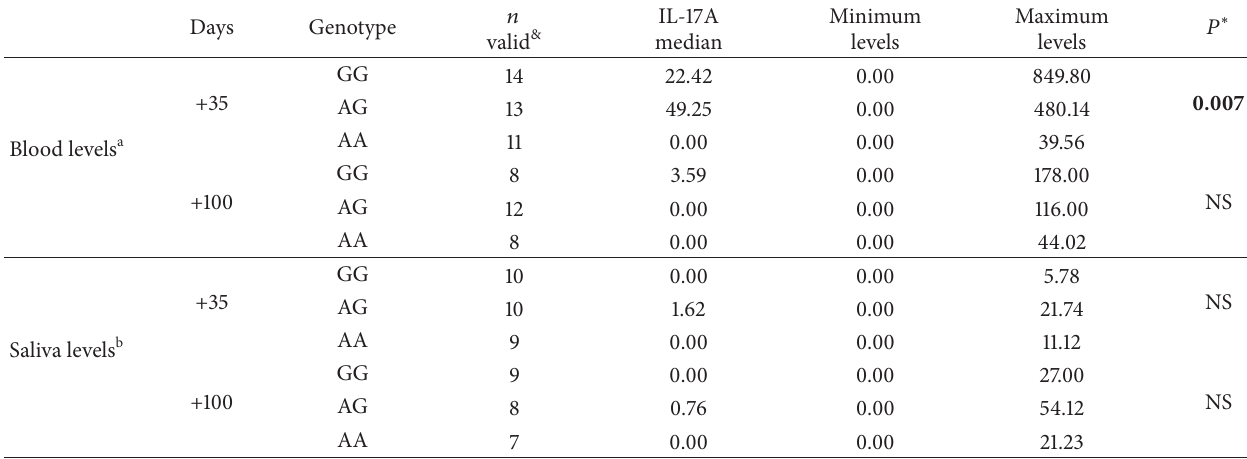
Table 3: Association between saliva IL-17A levels and recipient IL17A genotypes ( 𝑛 = 34 ). Days